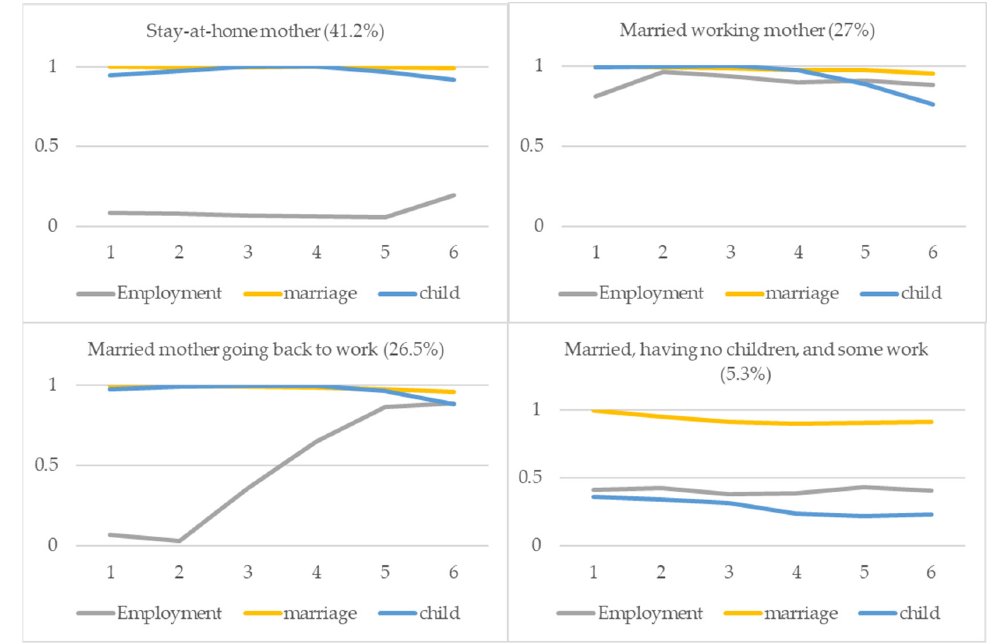
Figure 2. Married women’s work and family pathways.